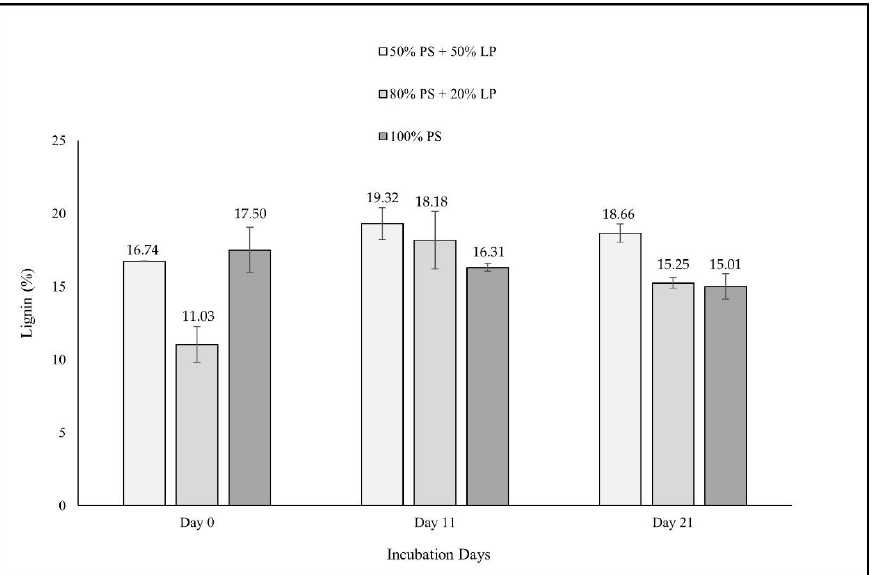
Figure 9. Assessment of Lignin content for PS and its mixtures with LPs. Statistical analysis was performed for each substrate individually between Day 0 and Day 21.